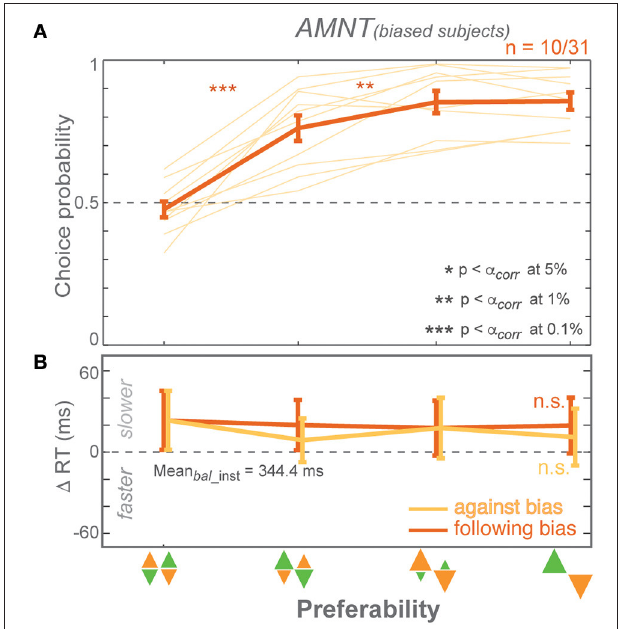
FIGURE 6 | Biasing effects on movement times (MT) instructed against trials of the PROB task. Zero line indicates average MTs in instructed trials of zero-bias condition. Dark and light colors represent follow and against responses, respectively. Error bars depict standard errors. ( * p < α corr at 5%, ** p < α corr at1%, *** p < α corr at0.1%,paired t -testwith Bonferroni